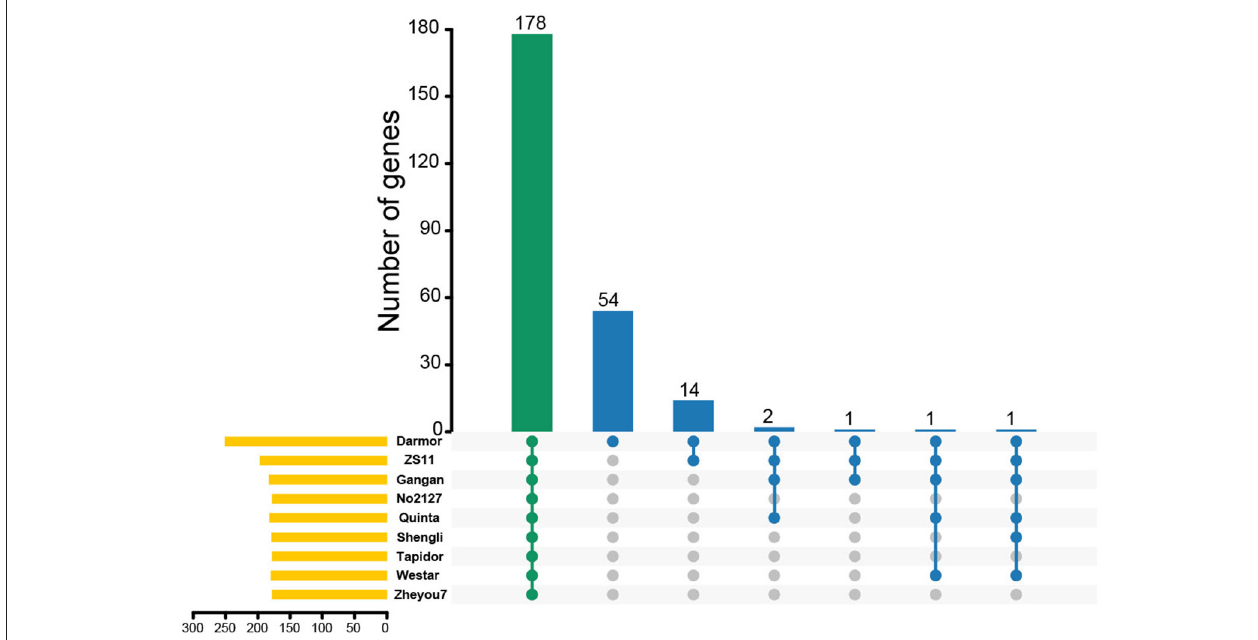
FIGURE 4 | The Upset plot shows the distributions of homologous MYB-related genes in different rapeseed accessions. The bar chart above represents the number of common homologous genes shared among different rapeseed accessions. The left bar chart at the bottom represents the number of homologous genes in each accession. The right dotted line at the bottom shows the number of accessions contained in the